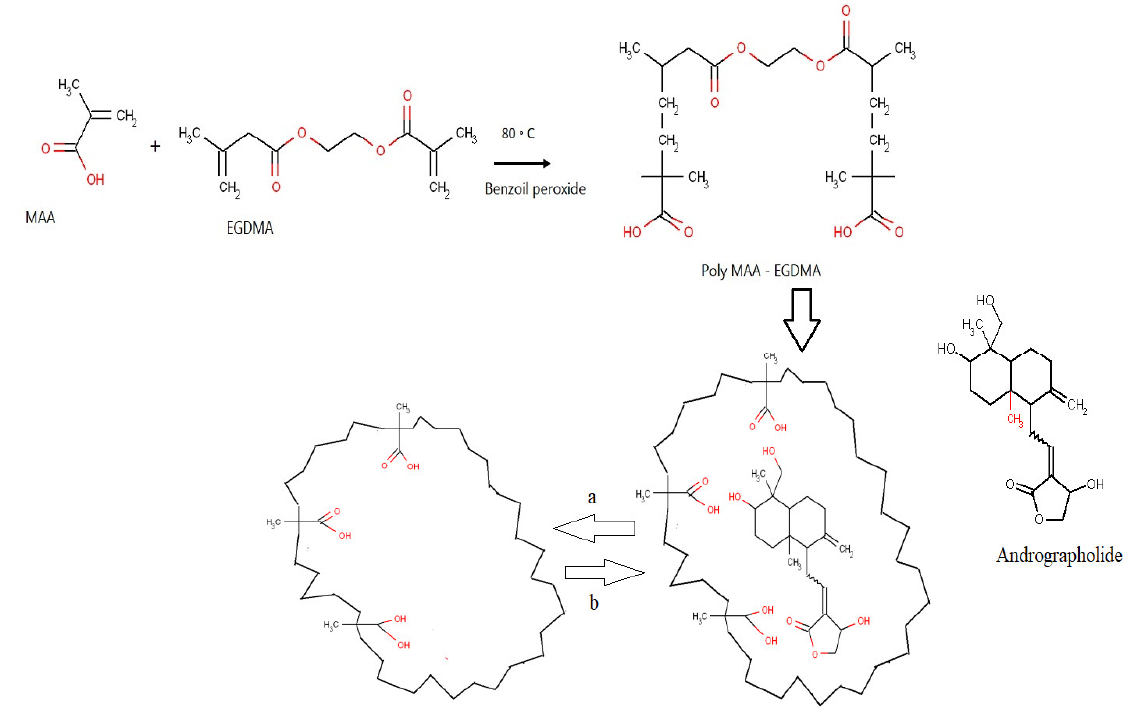
Figure 3. Proposed scheme of reaction of MIP synthesis; a: extraction of template molecule; b: rebinding of template molecule.